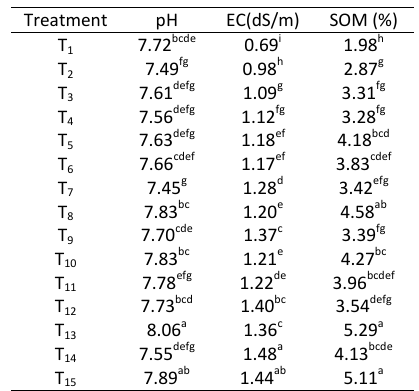
Table 4: Comparison of means of soil pH, EC and organic matter under different treatments